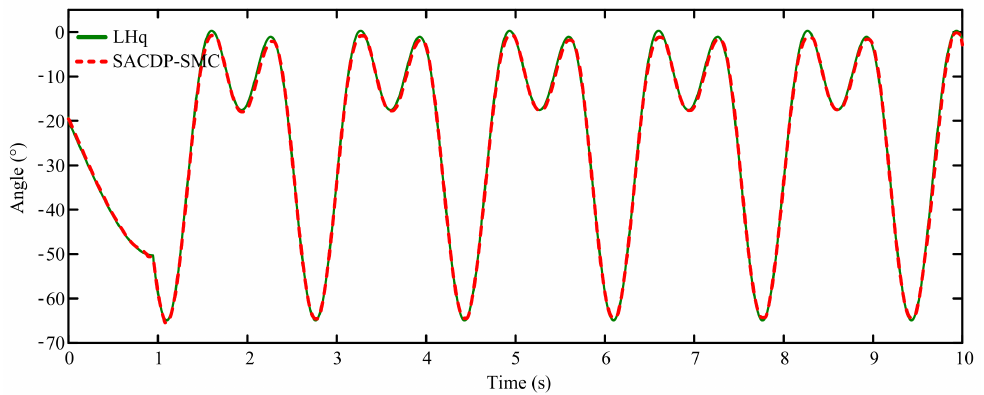
Figure 13. Trajectory tracking curve of the left knee